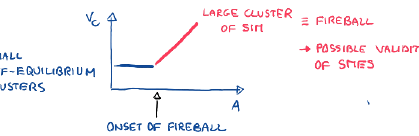
Figure 4. Concept of onset of fireball. Until a certain mass number, only small, o ff -equilibrium clusters are created. Only when a mass number corresponding to onset of fireball will large clus- ters of strongly interacting matter be created.